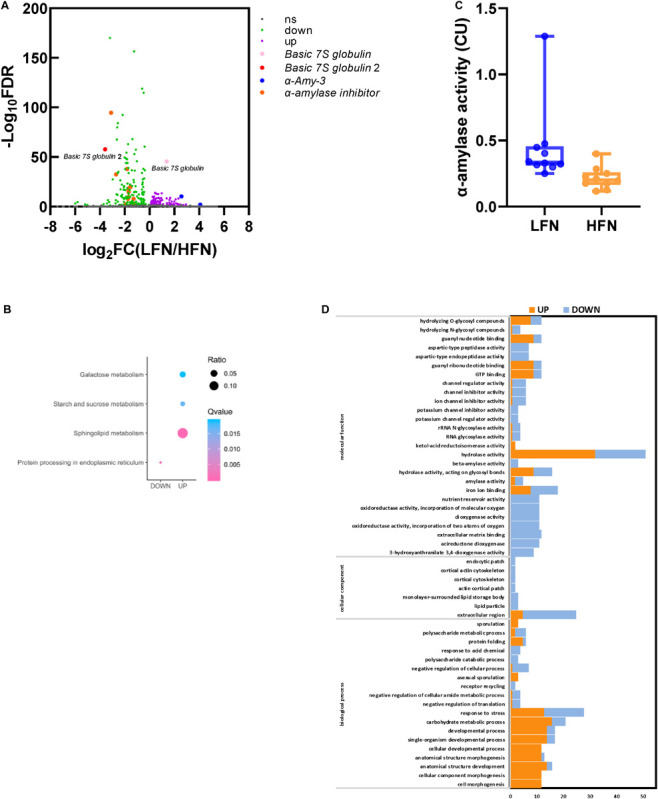
DEGs between the LFN and HFN bulk and α-amylase activity analysis. (A) Volcano plot of DEGs; ns represents no significant DEGs (FDR > 0.05). (B) KEGG enrichment analysis of DEGs. (C) GO enrichment analysis of DEGs. (D) α-Amylase activity analysis between 10 lines of the LFN and HFN bulk.